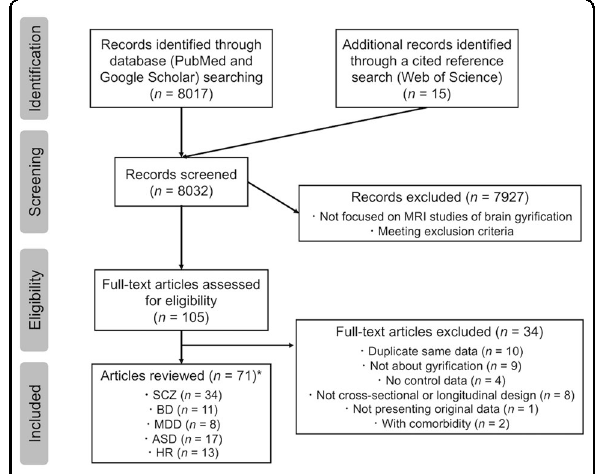
Fig. 1 Preferred reporting items for systematic reviews and meta- analyses (PRISMA) diagram for study search. *Ten studies investigated the gyri fi cation patterns in two or three psychiatric conditions (major psychiatric disorder or high-risk state for psychosis). ASD autism spectrum disorder, BD bipolar disorder, HR high risk for psychosis, MDD major depressive disorder; MRI magnetic resonance imaging, SCZ schizophrenia.